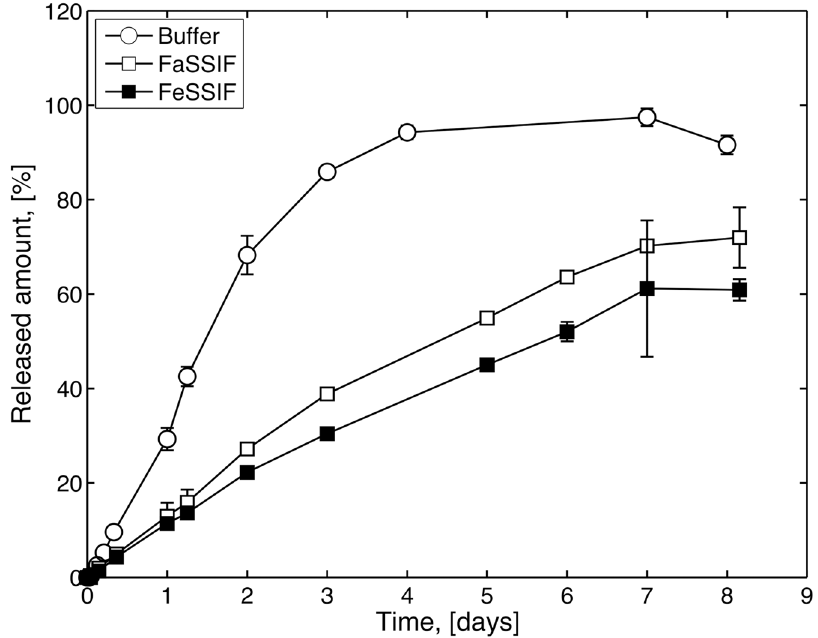
Fig 6. Release of griseofulvin from tablet without SDS (Formulation 1) in buffer (open circles), FaSSIF (open square) and FeSSIF (filled square). Error bars represent standard deviation (n = 2).